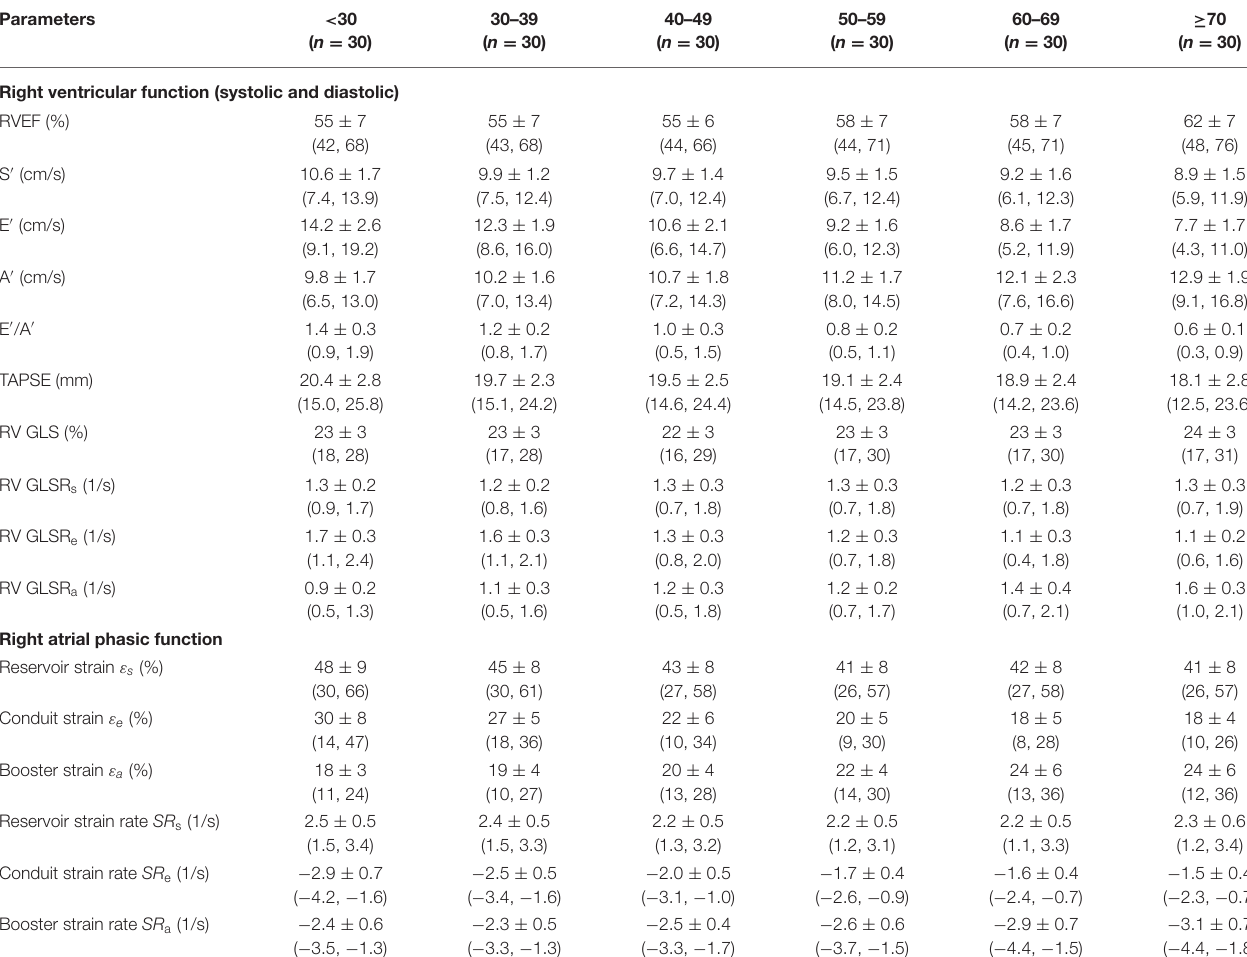
TABLE 2 | Males: right heart function parameters by age group [mean ± SD (reference range, lower/upper limits calculated as mean ± 1.96 · SD)].